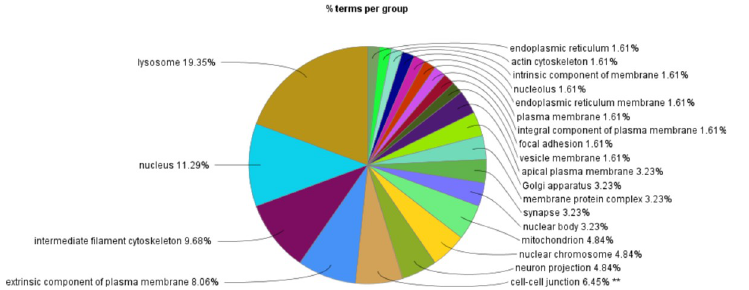
Fig 7. GO-cellular component. �� P < 0.01.